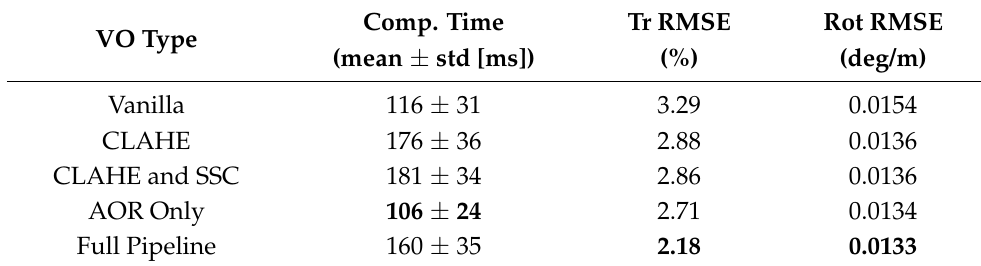
Table 3. Computation time comparison for KITTI